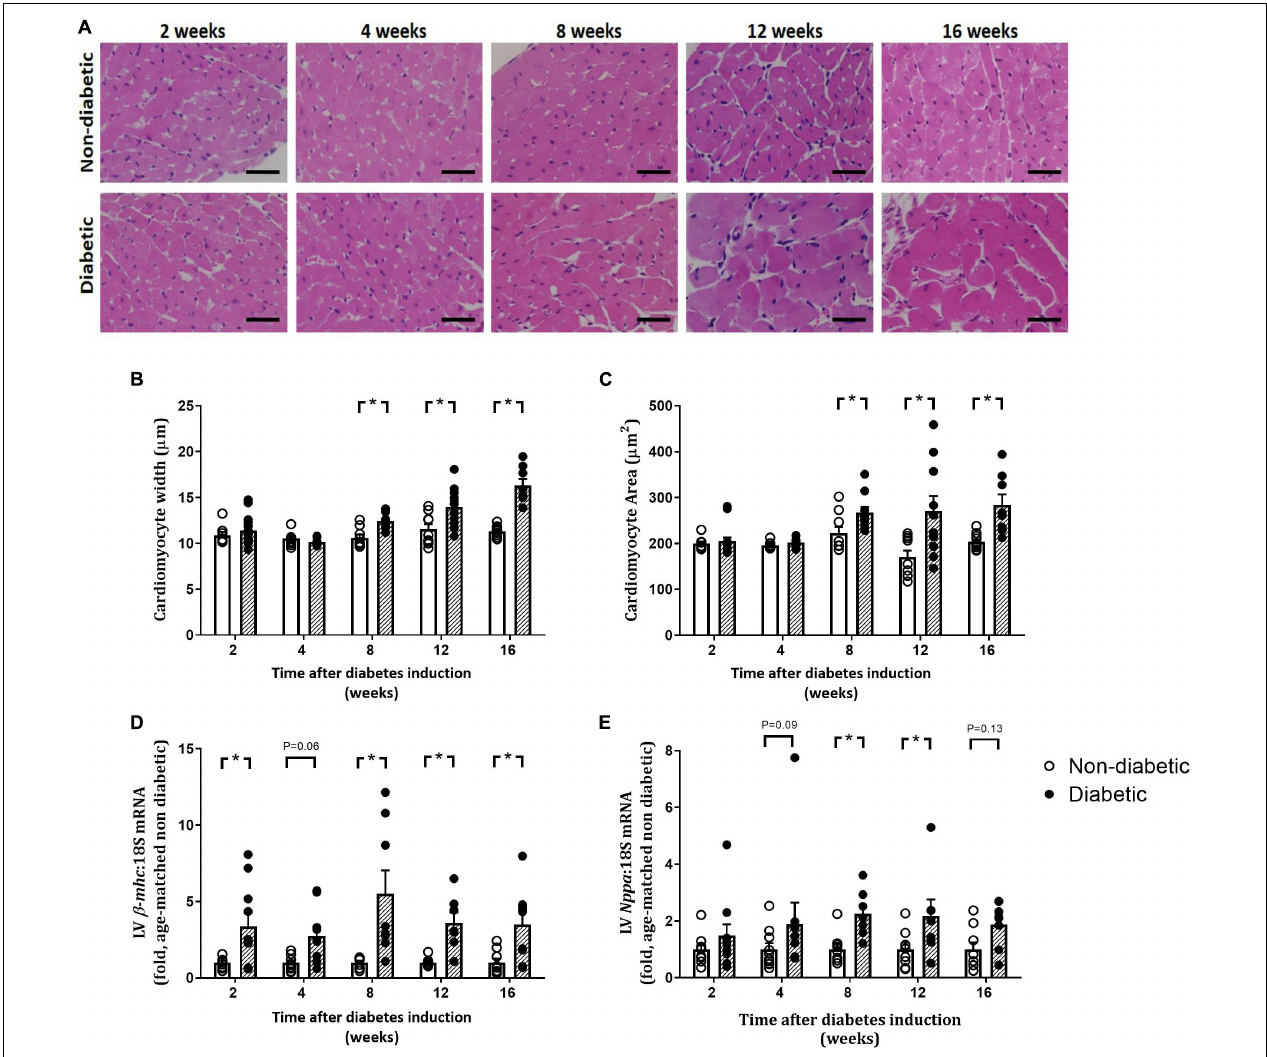
FIGURE 5 | Progression of cardiomyocyte hypertrophy. Cardiomyocyte width and area, from H&E-stained LV sections (A–C) , gene expression of hypertrophic markers β -myosin heavy chain, β -mhc (D) and Nppa (E) are shown. Data are presented as mean ± SEM. * P < 0.05 vs age-matched non-diabetic mice (two-way ANOVA with Benjamini and Hochberg post hoc test). Representative H&E images (A) for each endpoint are shown. Scale bar = 20 µ m. n = 7–15/group (refer to Supplementary Figure S1